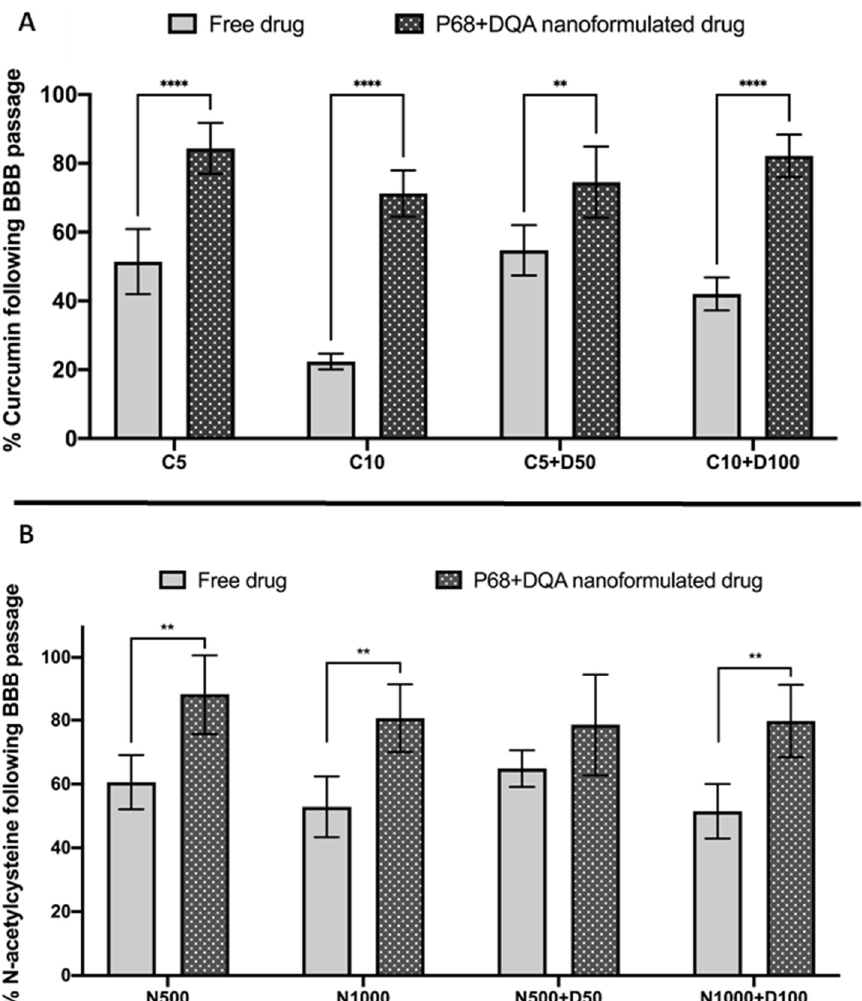
Figure 4. ( A ). Mean percentage of curcumin in the basolateral compartment of the hCMEC/D3 Transwell ® system following 60 min treatment with free or P68 + DQA curcumin (5 and 10 µ M) and combined curcumin and DFO (5 and 10 µ M curcumin + 50 and 100 µ M DFO, respectively). ( B ) Mean percentage of NAC in the basolateral compartment of the hCMEC/D3 Transwell ® system following 60 min treatment with free or P68 + DQA NAC (500 and 1000 µ M) and combined NAC and DFO (500 and 1000 µ M NAC + 50 and 100 µ M DFO, respectively). Percentage curcumin or NAC = ((absorbance of the basolateral compartment sample − control)/(absorbance of the treatment − control)) × 100, where the absorbance was read at 423 for curcumin or 234 nm for NAC and the control was MEM. * represents significance values of nanoformulated drug compared to free